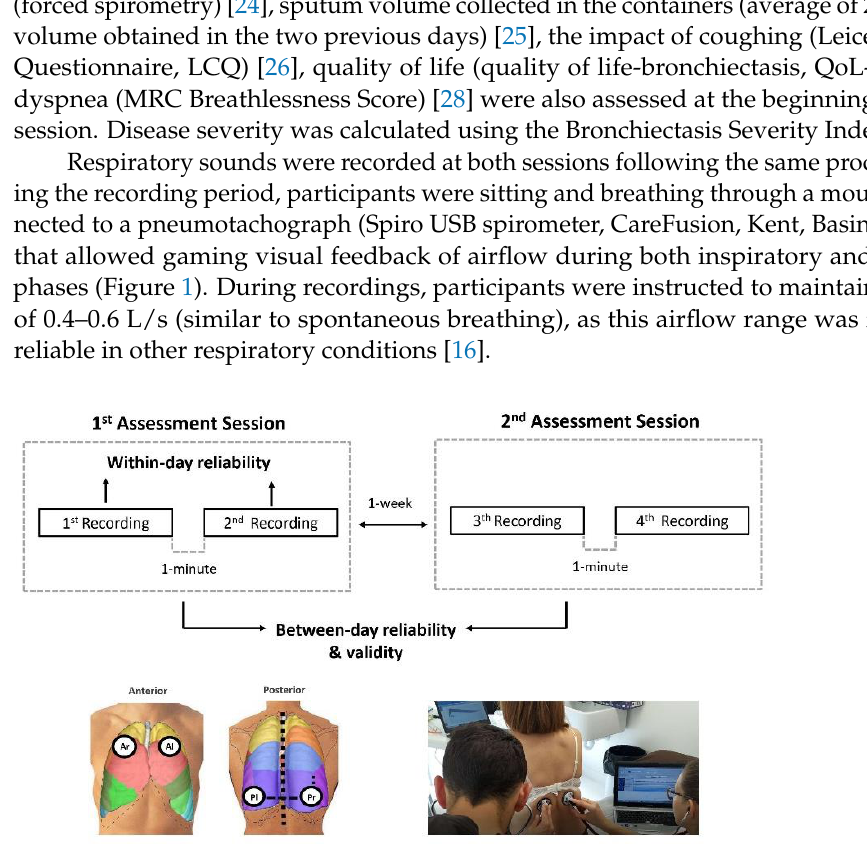
Figure 1. Study design. Overview of respiratory sounds collection for within-day and between-day reliability and construct validity. Anterior ( right and left ) and posterior ( right and left ) chest locations were recorded simultaneously for 25 s using two electronic stethoscopes. Within-day reliability was analysed using the two recordings from the first assessment session. Between-day reliability was analysed using the mean values of assessment session 1 (1st and 2nd recording) and the mean values of assessment session 2 (3rd and 4th recording). Construct validity was analysed using the mean values of the four recordings (1st, 2nd, 3rd and 4th recording) performed in both assessment sessions. Ar, anterior ( right ); Al, anterior ( left ); Pl, posterior ( left ); Pr, posterior ( right ). Two trained physiotherapists recorded the respiratory sounds at four standardized chest locations (i.e., right and left: anterior and posterior chest) [30] (Figure 1) with